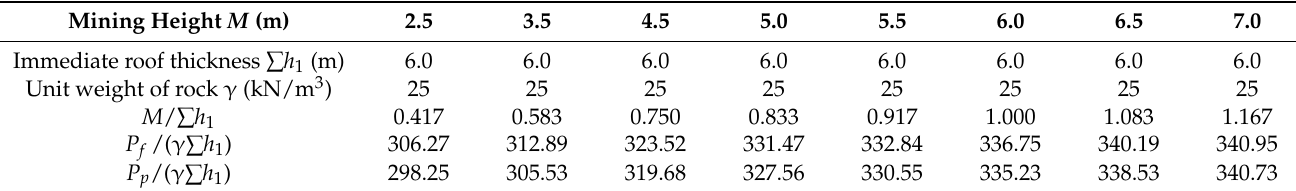
Table 4. Formula fitting